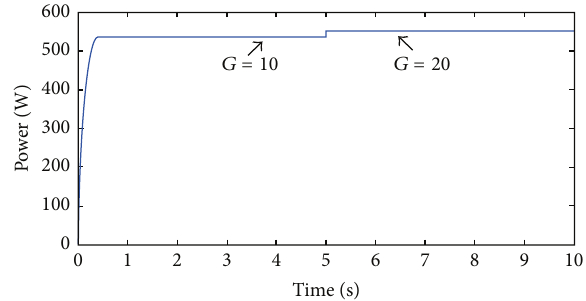
Figure 7: FC output power response given step change in operating temperature.